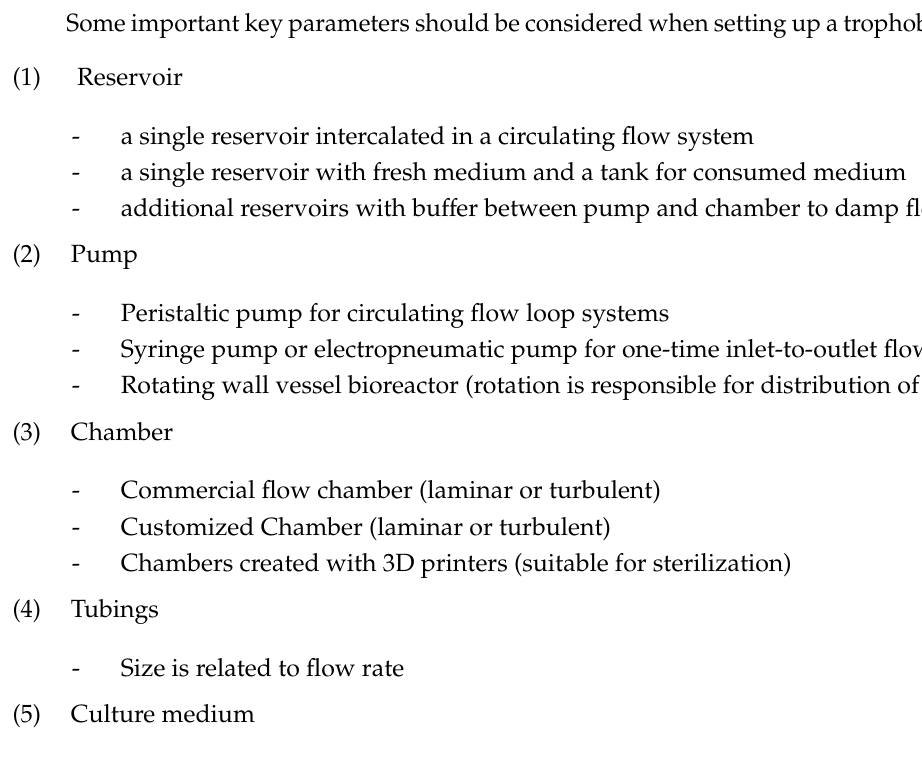
Figure 2. Influence of fluidic flow on di ff erent trophoblast subtypes. Fluidic flow regulates di ff erentiation and physiology of both, the syncytiotrophoblast (STB) and extravillous trophoblasts (EVTs). During syncytialization, cell-cell contact proteins, such as desmoplakin and E-cadherin are downregulated, and the structural protein ezrin relocalizes from the basal to the apical side. Formation and appearance of microvilli on the apical surface as well as accumulation of lipid droplets in the STB are influenced by fluidic flow. Moreover, fluidic flow a ff ects expression and localization of GLUT1, secretion of hCG as well as conversion of cortisol to cortisone. In the EVT subpopulation, formation of filopodia, and hence migratory behavior is regulated by fluidic flow as